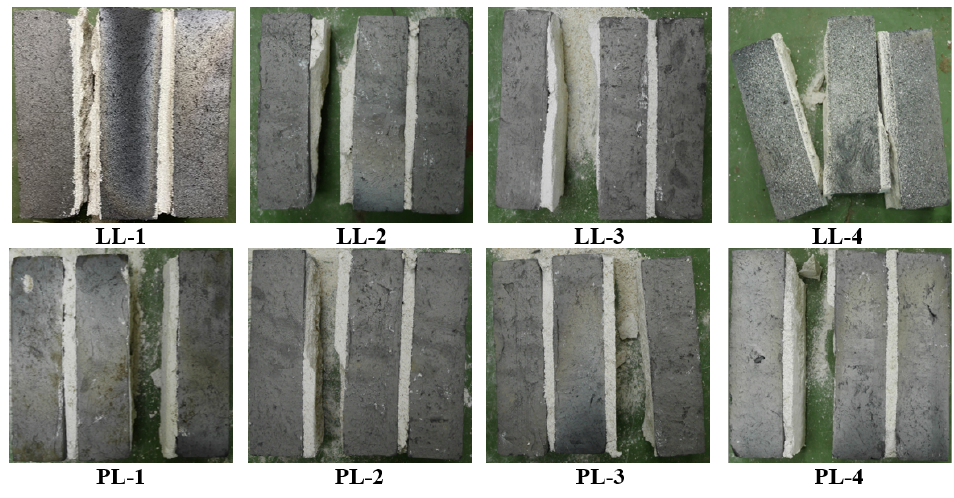
Figure 18. Failure mode of Triplet shear